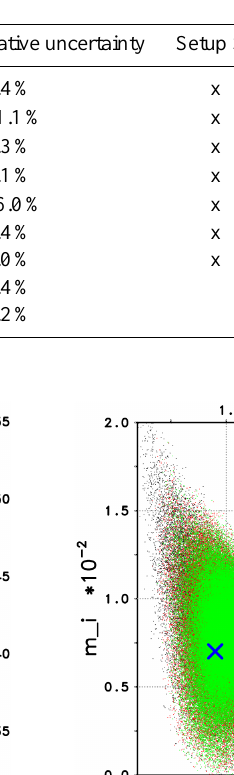
Table 2. Simulated lidar-relevant optical properties and attributed uncertainties used as input (calculated from the “truth” ensemble) for the retrieval in Sect. 3; parameters are the extinction coefficient, α , backscatter coefficient, β , and linear depolarization ratio, δ l , at different wavelengths; S1, S2, S3 denote the different lidar setups described in Sect. 2.